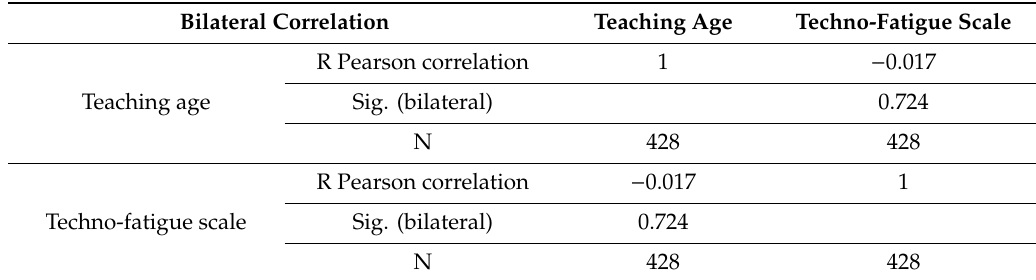
Table 7. Bilateral correlation between teaching age and